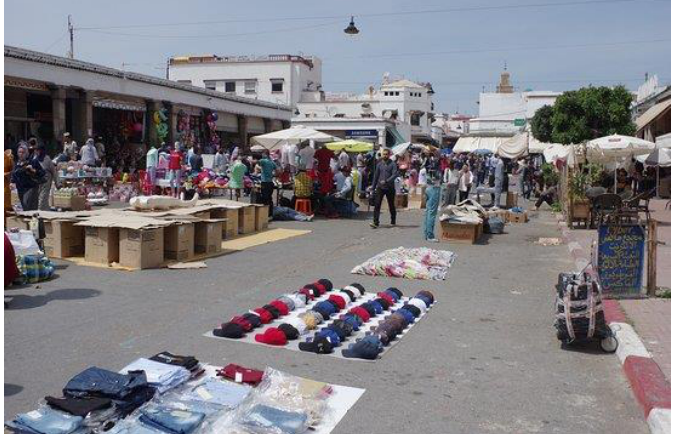
Figure 6: informal economi activities-marché